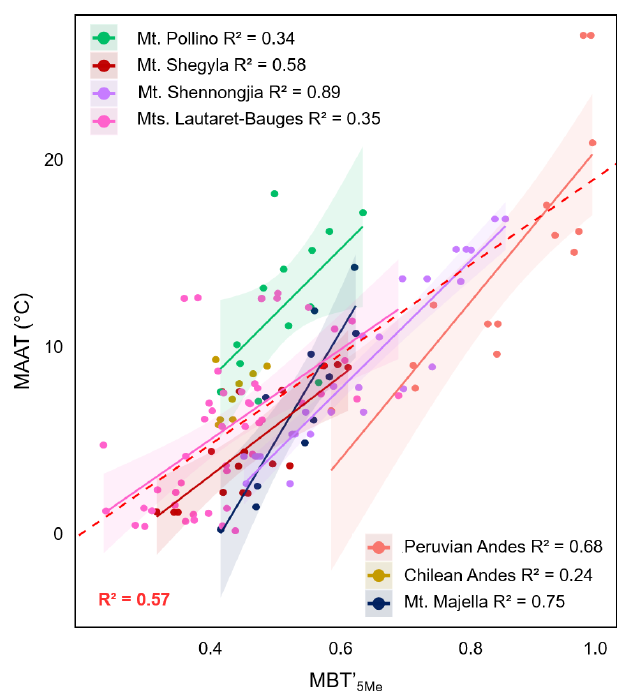
Figure 6. Linear regressions between (a) MAAT and MBT’ 5Me along seven of the eight altitudinal transects investigated. Data from Mt. Rungwe (Coffinet et al., 2014), for which 5- and 6-methyl brGDGTs were not separated, were not included in this graph. Dot- ted lines represent the 95% confidence interval for each regres- sion, and coloured areas represent the 95% confidence interval for each regression. Data from Mt. Majella were taken from Huguet et al. (2019). Data from Mt. Bauges and Mt. Lautaret-Galibier were taken from Véquaud et al. (2021). Data from Mt. Shennongjia were taken from Yang et al. (2015). The global soil calibration by De Jonge et al. (2014) was applied to all these transects. Only signifi- cant regressions ( p < 0 . 05) are